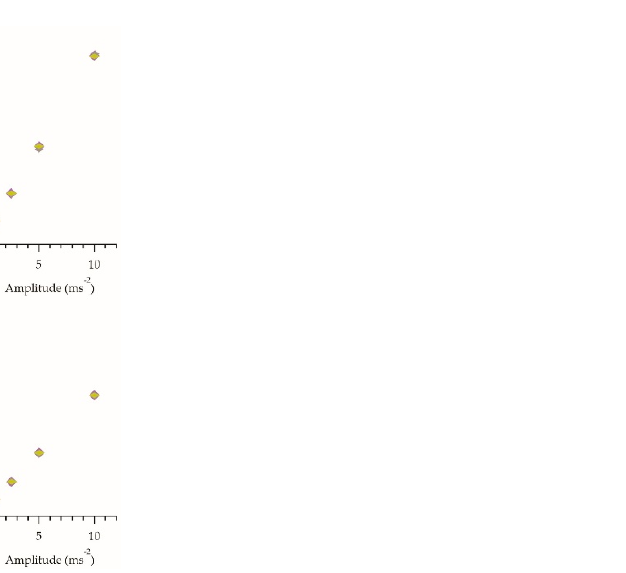
Figure 6. Repeat measurements taken using a single vibration-sensing E-yarn where the measure- ments were taken in different orders: sequential (as described in the methods section), reverse sequential and random order . All data have been recorded in the z-axis only. ( a ) Fre- quency response data. ( b ) Amplitude response at 80 Hz. ( c ) Amplitude response at 800 Hz. ( d ) Amplitude response at 1250 Hz.